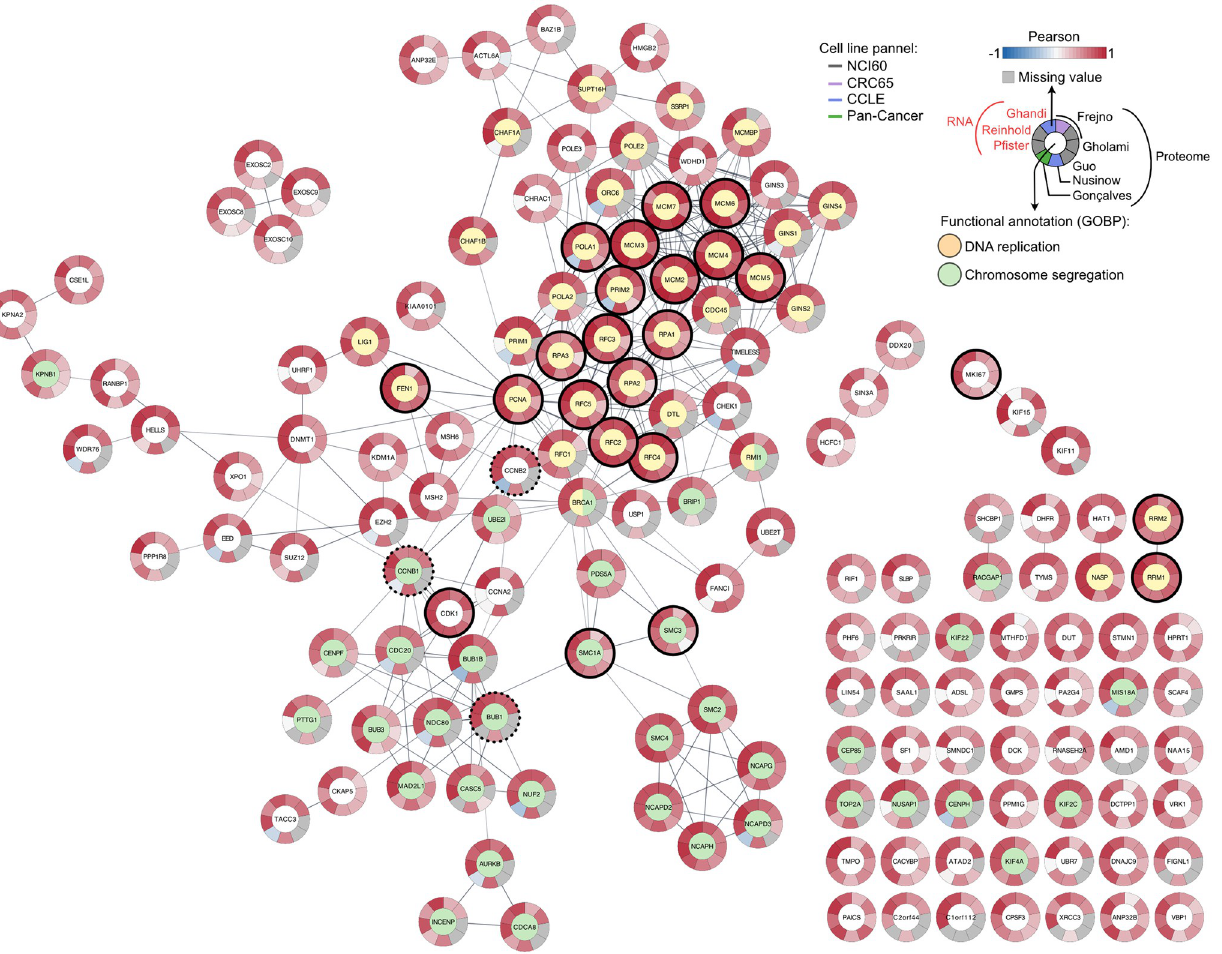
Fig 3. Proliferation signature. STRING subnetwork of physical interactions (score � 0.7) corresponding to the proliferation signature as selected in Fig 2. The genes used to calculate the pseudo-proliferation index and the known proliferation markers not included for pseudo-proliferation index calculation are highlighted by black solid and dashed borders, respectively. The nodes are color-coded by selected gene annotations of biological processes. External ring are the Pearson correlations for each data set independently.